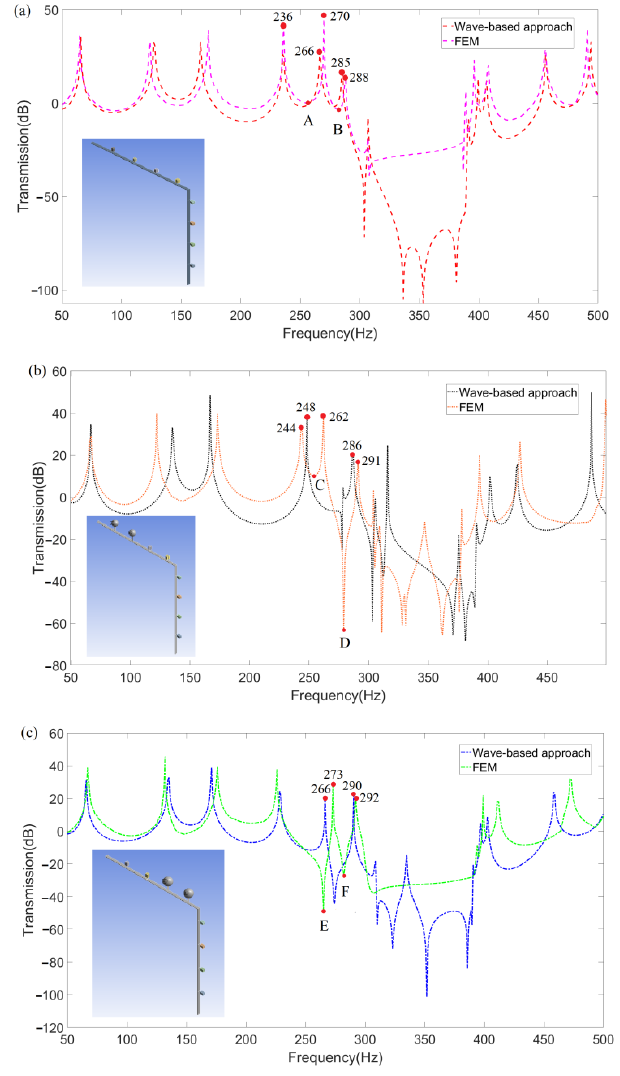
Figure 12. The FRFs of the LR beam using the wave-based method and FEM ( a ) suspended with transverse-force type resonators, ( b ) suspended with longitudinal-force-moment type resonators set at the first two cells, ( c ) suspended with longitudinal-force-moment type resonators set at the third and fourth cells.